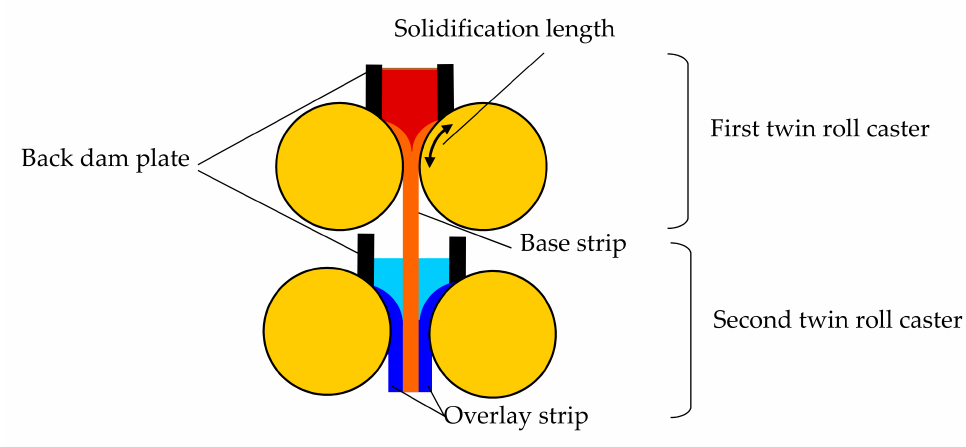
Figure 1. Schematic illustration of a vertical-type tandem twin roll